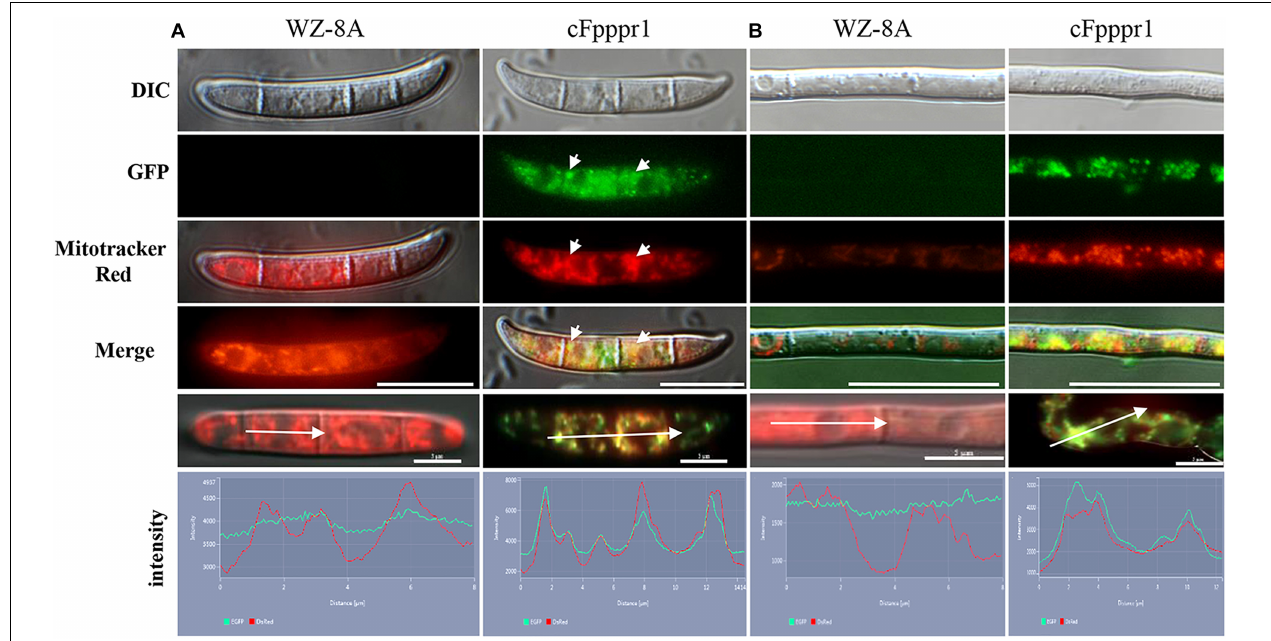
FIGURE 4 | The localization of FpPpr1-GFP in F. pseudograminearum. Mito-tracker Red CMXRos M7512 staining on spores (A) and hyphae (B) . The spores were harvested from CMC medium into 50 mL microcentrifuge tubes and filtered through single-layer sterile Miracloth, centrifuged at 2,500 g , and resuspended with 1 mL of PBS and centrifuged again. The fresh spores were resuspended in prewarmed Mito-Tracker Red CMXRos M7512 (200 nM in PBS from the stock solution at –20 ◦ C protected from light) at 1 × 10 5 spores/mL after two washes and incubated at 37 ◦ C (MitoTracker mitochondrion-selective probes, Invitrogen) for 10 min following the kit instructions. The conidia were pelleted at 5,000 g for 3 min and resuspended in 50 µ L of PBS for imaging via fluorescent GFPHQ green and TRITC red filters with a Nikon fluorescence Eclipse inverted Ti-S microscopy. Red signal indicates mitochondrial localization. Green signal indicates the expression of the